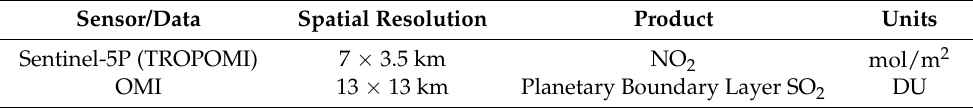
Table 1. Summary of the emissions data used in this